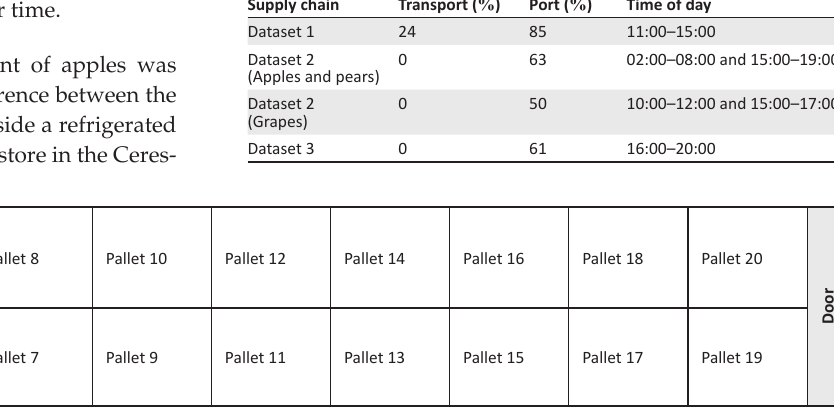
FIGURE 2: Pallet placement inside reefer